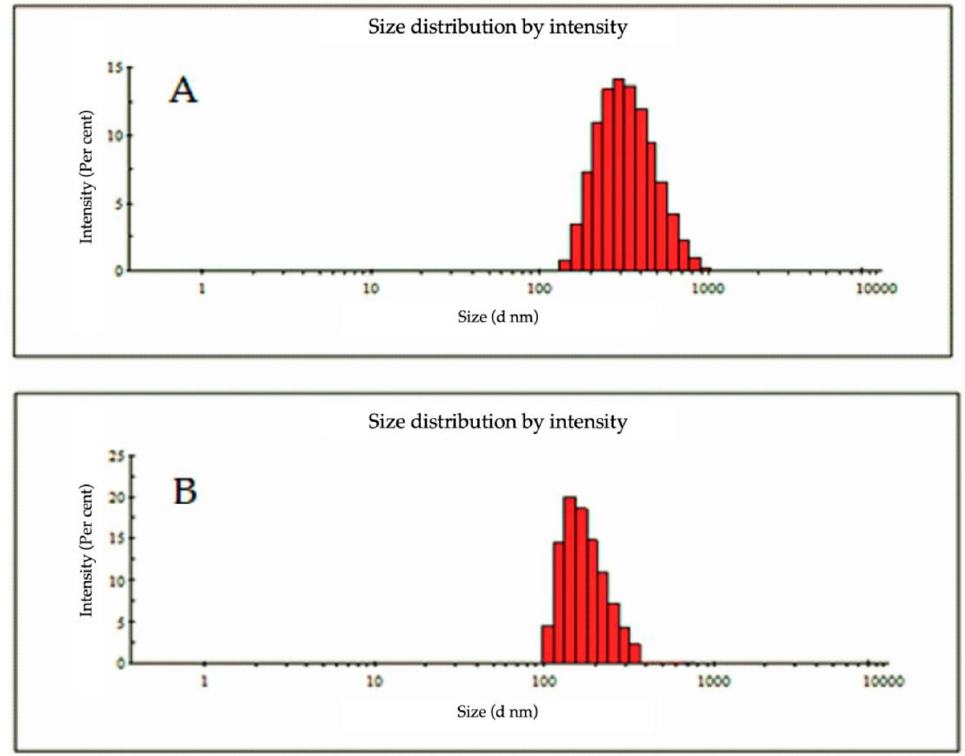
Figure 1. Representative DLS traces. ( A ) double emulsion-solvent evaporation (DESE) (ethyl acetate (EA), pH = 4); ( B ) polyelectrolyte complexation/ionic gelation